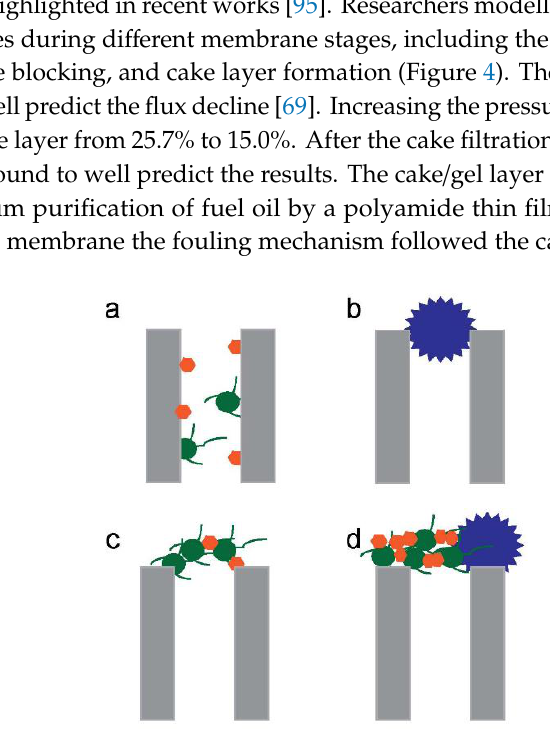
Figure 4. Di ff erent mechanisms of membrane fouling. ( a ) standard blocking, ( b ) complete blocking, Figure 4. Different mechanisms of membrane fouling. a) standard blocking, b) complete blocking, c) ( c ) intermediate blocking and ( d ) cake layer intermediate blocking and d) cake layer formation.